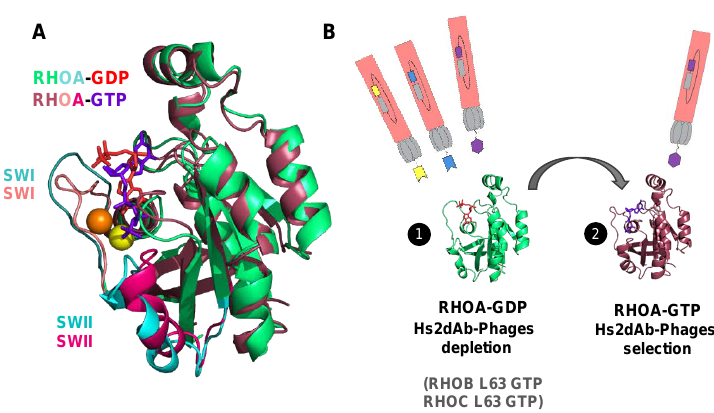
Figure 1. Antibody phage display selection of GTP-bound RHO conformational nanobodies. ( A ) View of the structure of RHOA-GTP V14 mutant (shown in wine-red and pink, Protein Data Base (PDB): 1a2b) superimposed with the structure of RHOA-GDP (shown in green and cyan, PDB: 1ftn). RHOA G14V mutant in the active state is bound to the GTP (purple-blue nucleotide) and Mg 2+ (shown as a yellow sphere). RHOA displays the inactive conformation bound to GDP (red nucleotide) and Mg 2+ (shown as an orange sphere). The structural alignment in this view shows a subtle closure of the switch I and switch II loops (SWI and SWII loops currently in cyan in RHOA-GDP and in pink in RHOA-GTP) around the phosphate gamma and the Mg 2+ (orange to yellow). ( B ) Scheme of the subtractive phage display enrichment of hs2dAb to GTP-bound RHOA (wine-red) by depletion with the inactive GDP-bound state (green) and with the GTP-bound state of RHOB and RHOC (see Methods). The phages presenting hs2dAb are shown in pink/grey. The RHOA structures were produced using PyMOL software 2.1 (Schrödinger, Mannheim,